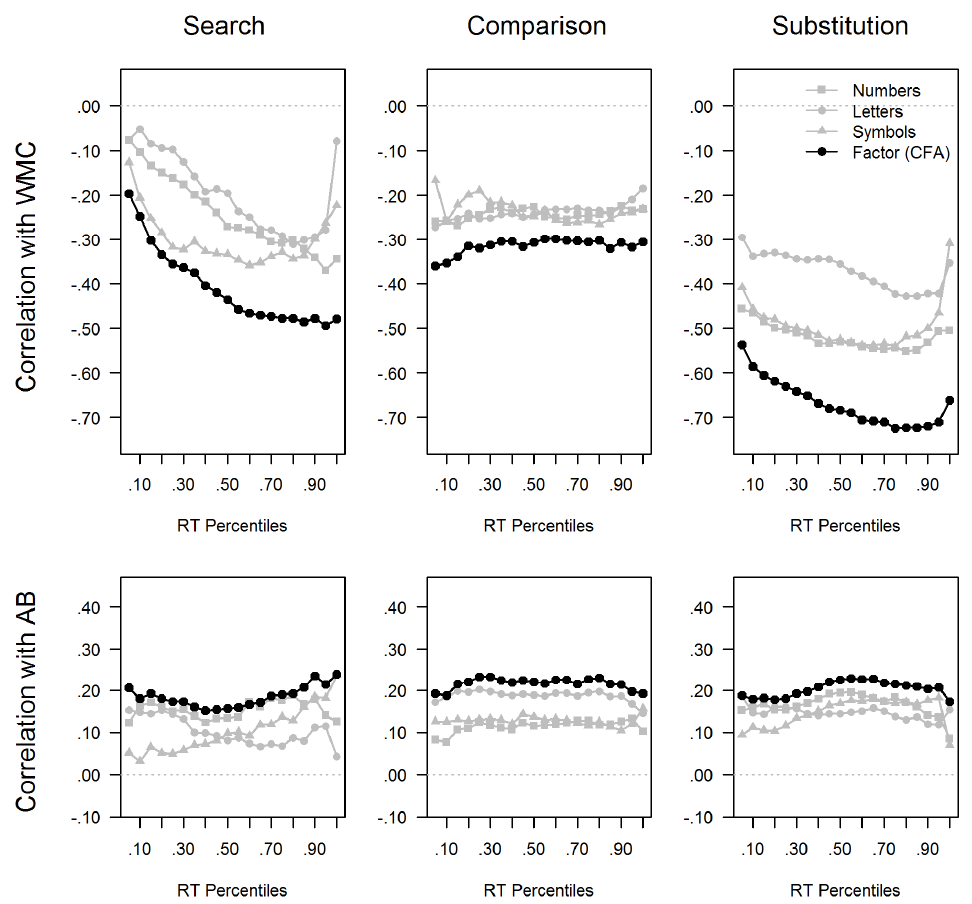
Figure 4. Correlations of RT Bands obtained in Mental Speed Tasks with WMC and AB. Factor (CFA) corresponds with a latent factor obtained in a confirmatory factor analysis using the three stimulus materials as observed indicators.